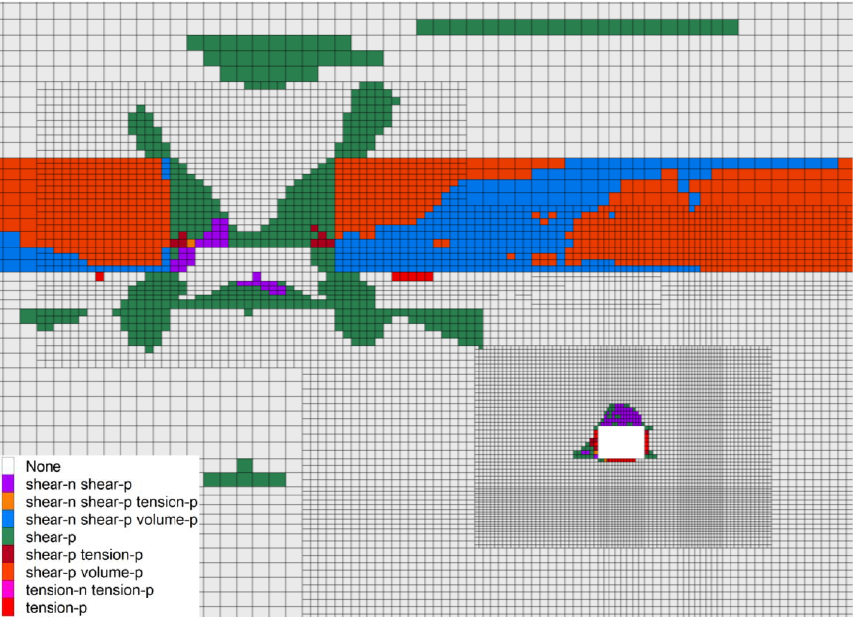
Figure 17. Plastic zone distribution cloud map when the coal column is 4 m. (2) The coal column is 8 m When the coal column is 8 m, the horizontal distance from the residual coal column is 27.85 m and the vertical distance is about 18.5 m. According to the stress cloud diagram (Figure 18), σ 1 and σ 3 appear at the residual coal column of the overlying coal seam, and σ 1 near the residual coal column is about 54 – 115 MPa; σ 3 is about 25 – 59 MPa. σ 1 around the roadway is about 6 – 18 MPa, and σ 3 is about 0.2 – 4 MPa.